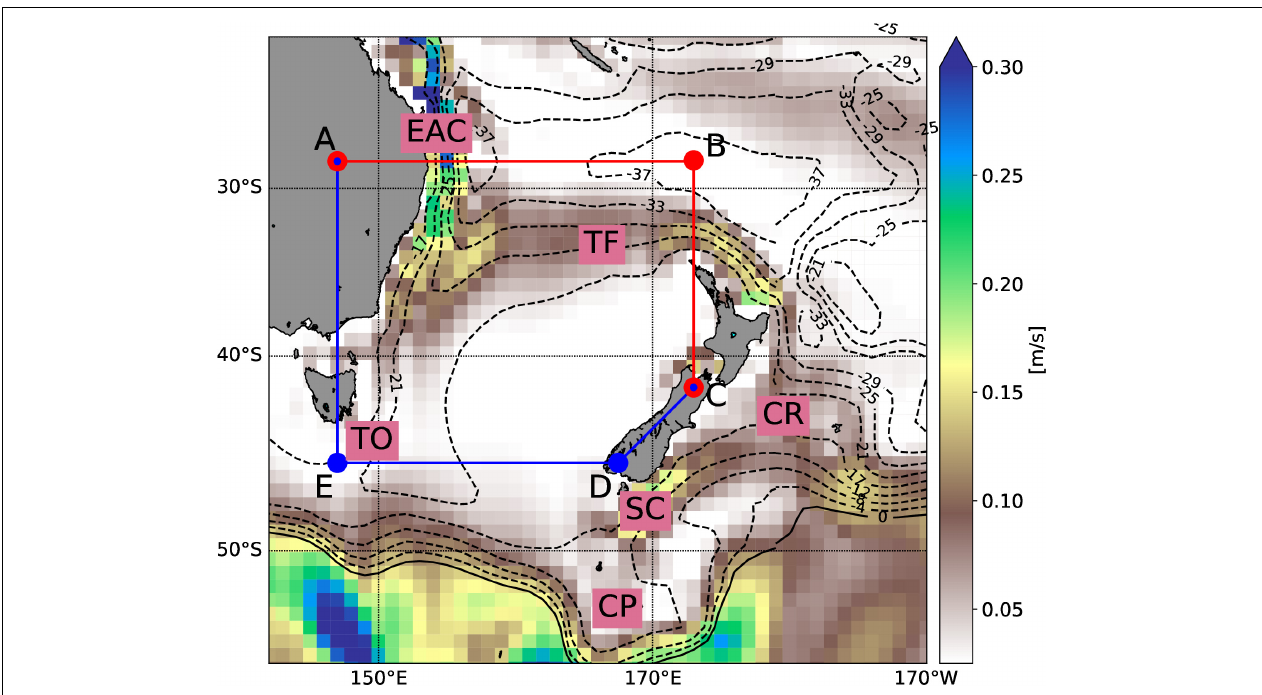
FIGURE 1 | Modeled mean surface speed (shading) in m/s with contour lines representing the barotropic stream-function in Sv. The area enclosed by the polygon ABCDEA is the area of interest for this study, thereafter the Tasman Box. The horizontal boundaries are split into a Tasman North (red lines and dots, section ABC) and Tasman South section (blue lines and dots, section CDEA). See Table 1 for coordinates. Labels EAC, TO, TF, SC, CP and CR mark the East Australian Current, Tasman Outflow, Tasman Front, Southland Current, Campbell Plateau and Chatham Rise, respectively. The Cook Strait is the passage between New Zealand’s North and South Island near corner point